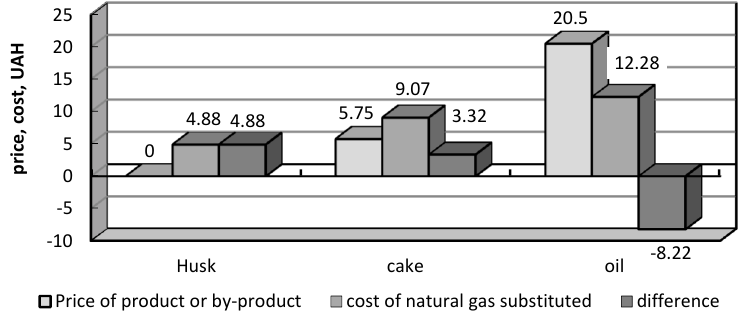
Figure 5. Market prices and cost of natural gas substituted.